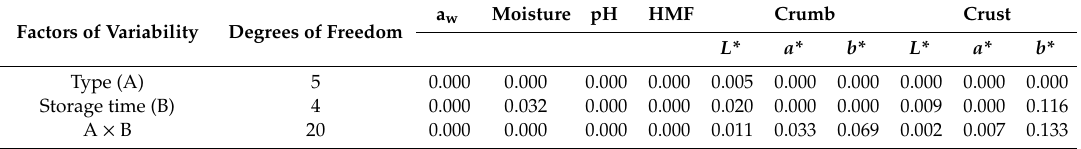
Table 7. Analysis of variance of the chemical and color parameters studied on the loaves ( p -values). a w Moisture pH HMF Crumb Factors of Variability Degrees of Freedom